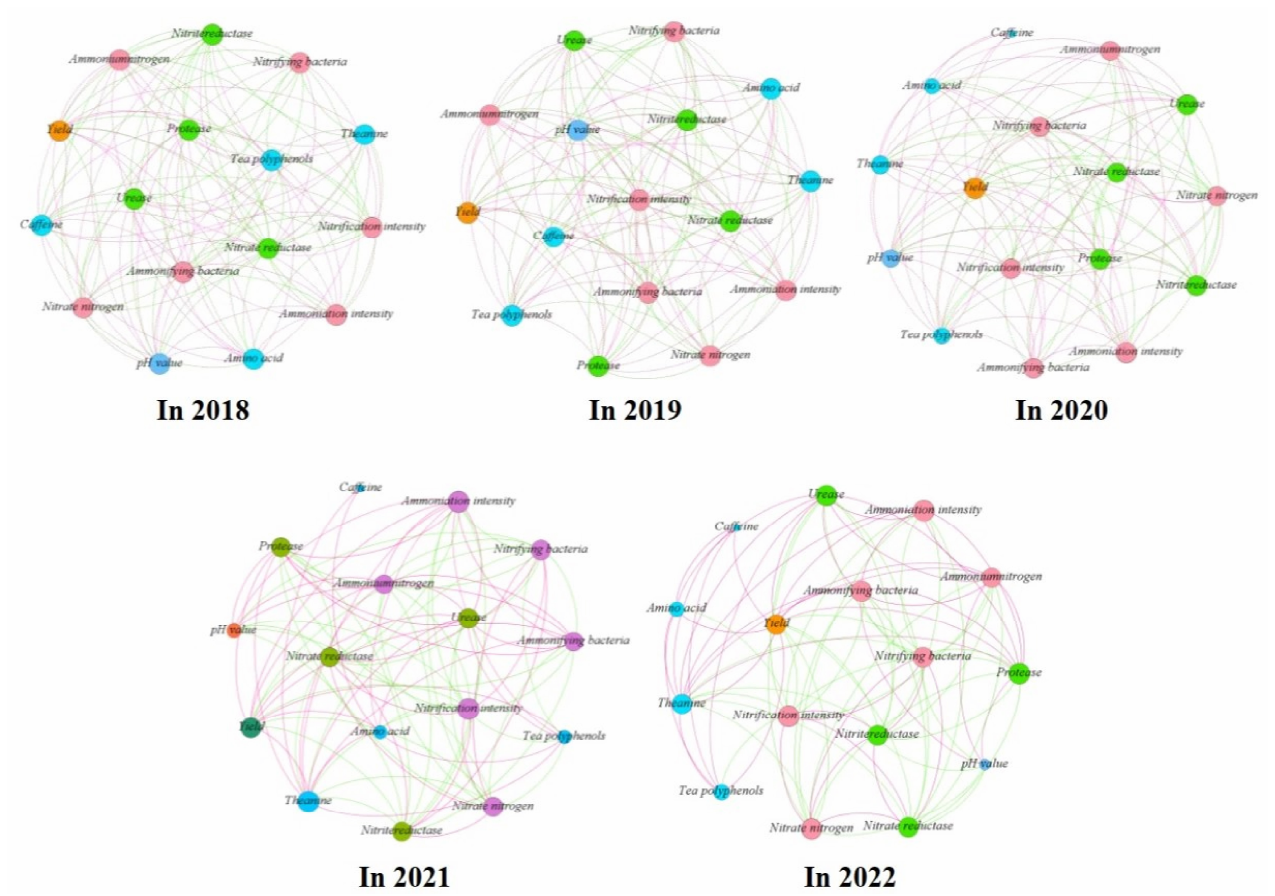
Figure 10. Interaction networks based on correlation analysis of soil and tea indexes of different years after the use of sheep manure fertilizer with different dosages. Note: positive correlation; negative